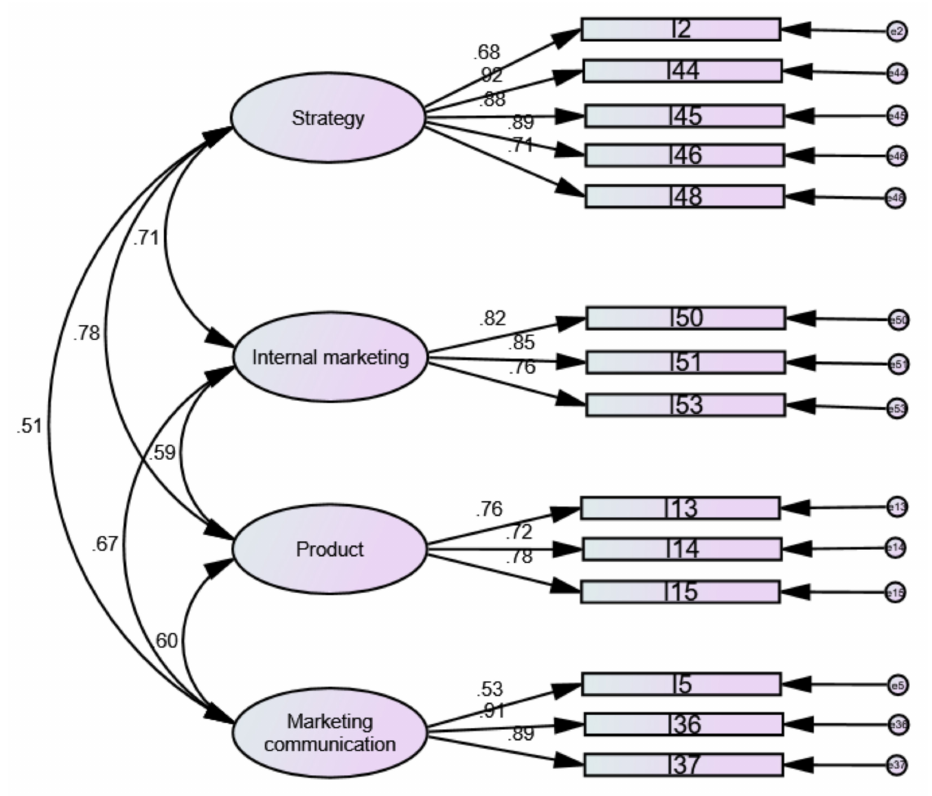
Figure 4. The final four-factor, 14 item confirmatory factor analysis (CFA) model of the Green Marketing Scale